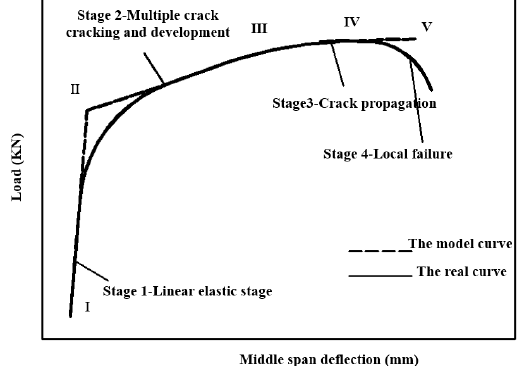
Figure 1. Bending load–deflection curve model of thin plate (ACK model).